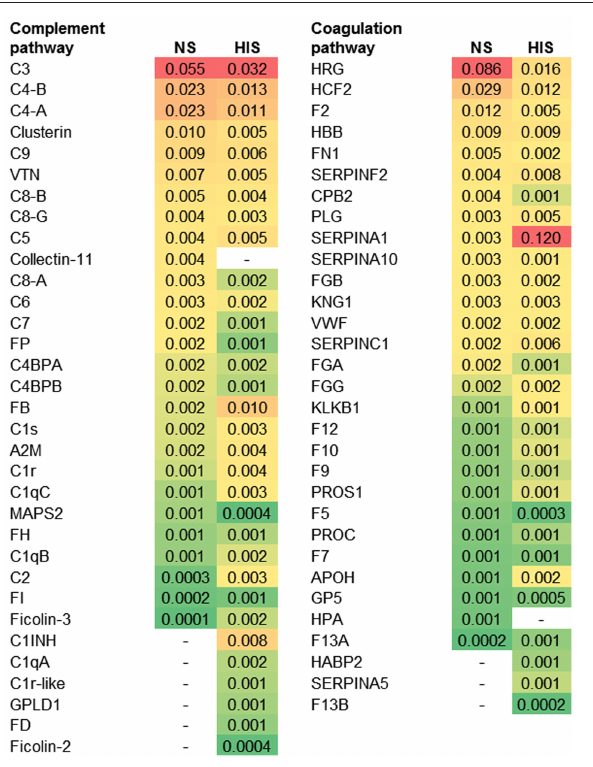
FIGURE 2 | Protein ranking of complement and coagulation proteins identified on normal serum (NS) and heat inactivated serum (HIS) samples according to the average of NSAF. C. albicans was incubated with 10% human serum at 37 ◦ C (normal serum-NS or heat inactivated serum-HIS) and NSAF was calculated for proteins belonging to complement and coagulation proteins. The proteins were ordered according to their NSAF obtained in NS samples, from more to less abundant. Gradient color ranges from red (more abundant) to green (less abundant).